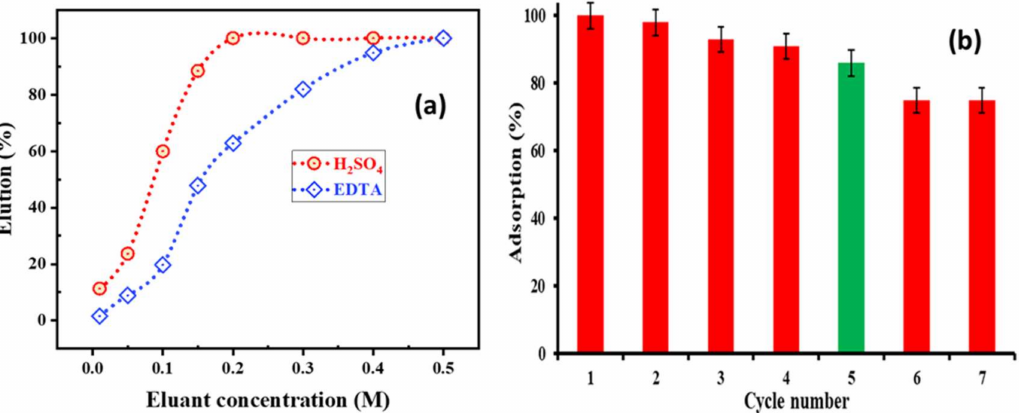
Figure 9. ( a ) Effect of eluents concentration on elution of cobalt loaded on PTU-MSA; ( b ) Reusability of